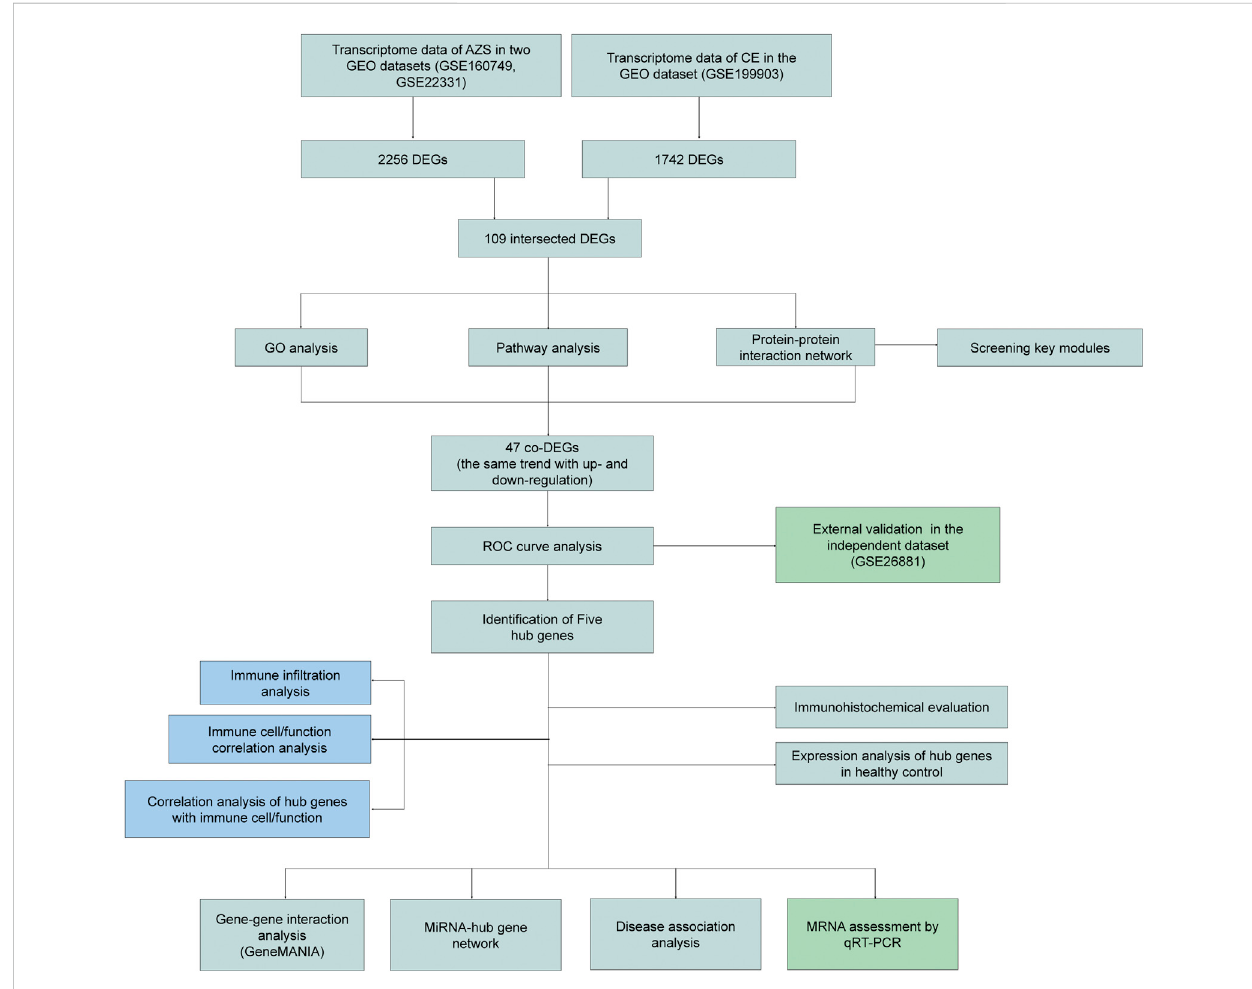
The fl ow diagram of study design. AZS: asthenozoospermia; CE: chronic epididymitis; GEO: Gene Expression Omnibus; GSE: GEO Series; DEGs: Differentially expressed genes; co-DEGs: co-expressed differentially expressed genes; GO: Gene Ontology; ROC: Receiver Operating Characteristic; qRT-PCR: quantitative real-time polymerase chain